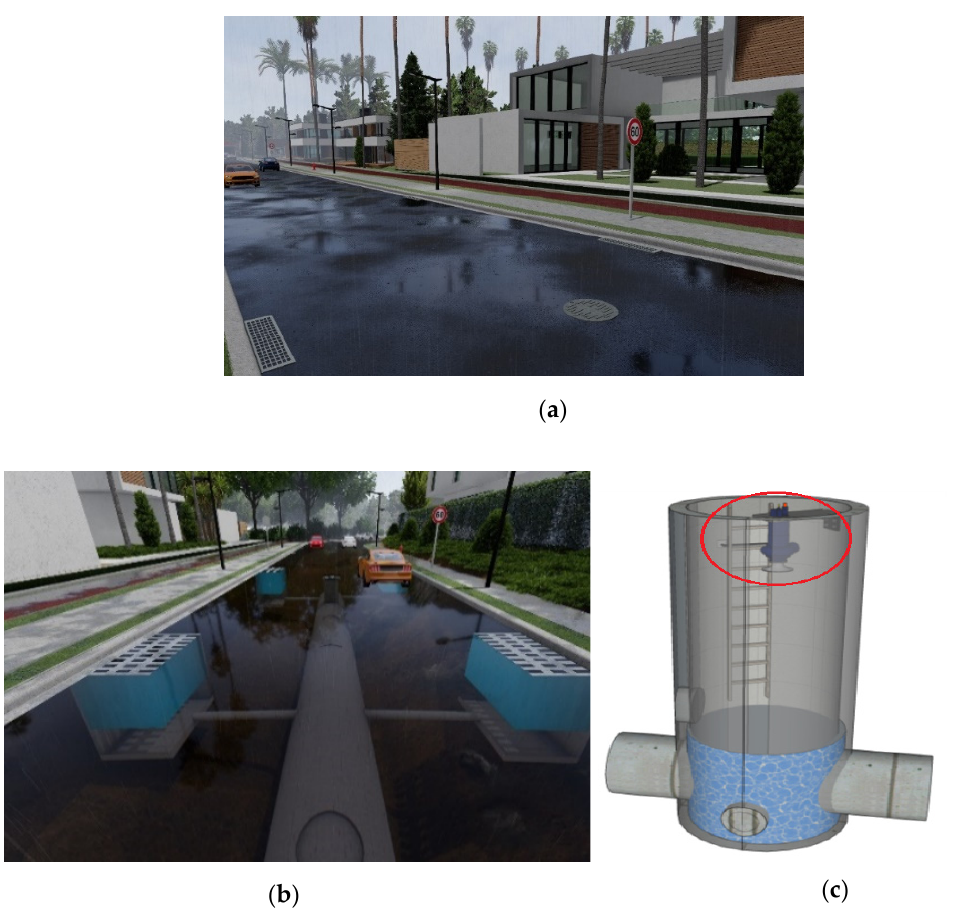
Figure 4. ( a ) Simulation for a street area with the drainage system. ( b ) Simulation for the drainage system in the street. ( c ) The real-time measuring system (ultrasonic sensor) located at the top of the water drainage system.